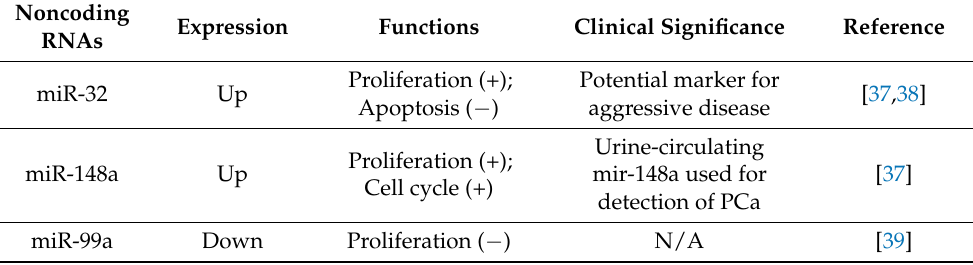
Table 1. The cellular functions and clinical significance of representative ncRNAs in